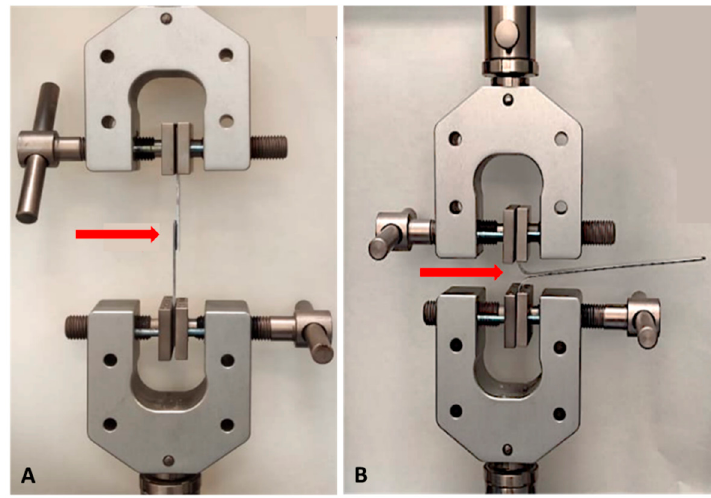
Figure 2. Example of adhesive shear ( A ) and T-peel ( B ) tests.